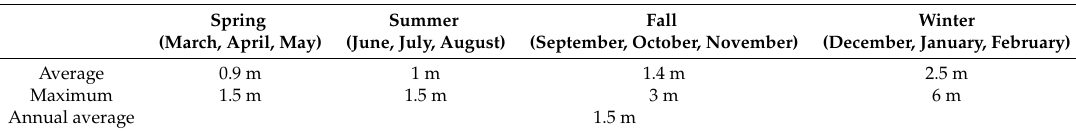
Table 1. Wave height of FL the South China Sea in different